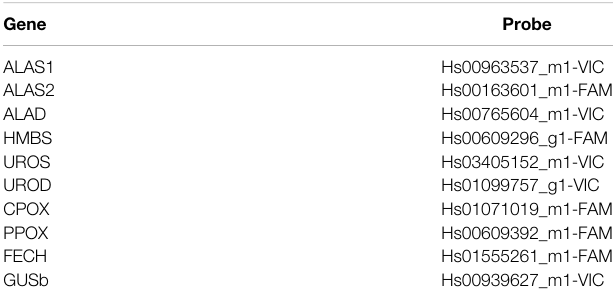
TABLE 2 | Gene expression TaqMan ® probes used in the